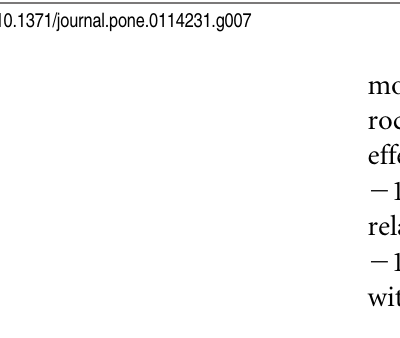
Figure 7. Effects of admixture with mivacurium on rocuronium onset time.